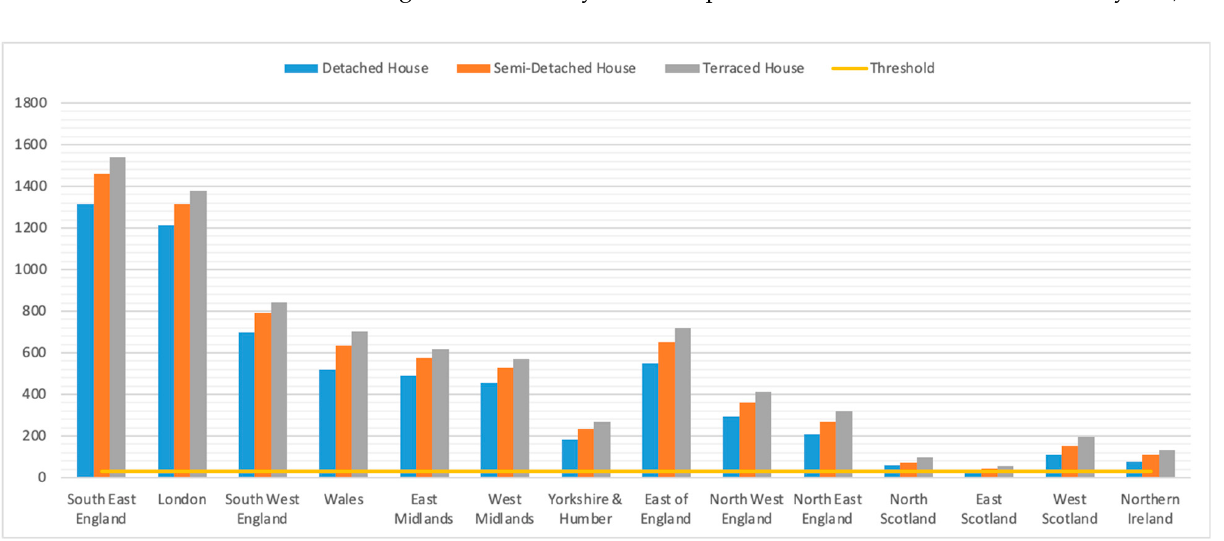
Figure 7. Base model annual bedroom overheating with PROMETHEUS 2050s, medium emissions climate data; line shows 32 h overheating threshold.